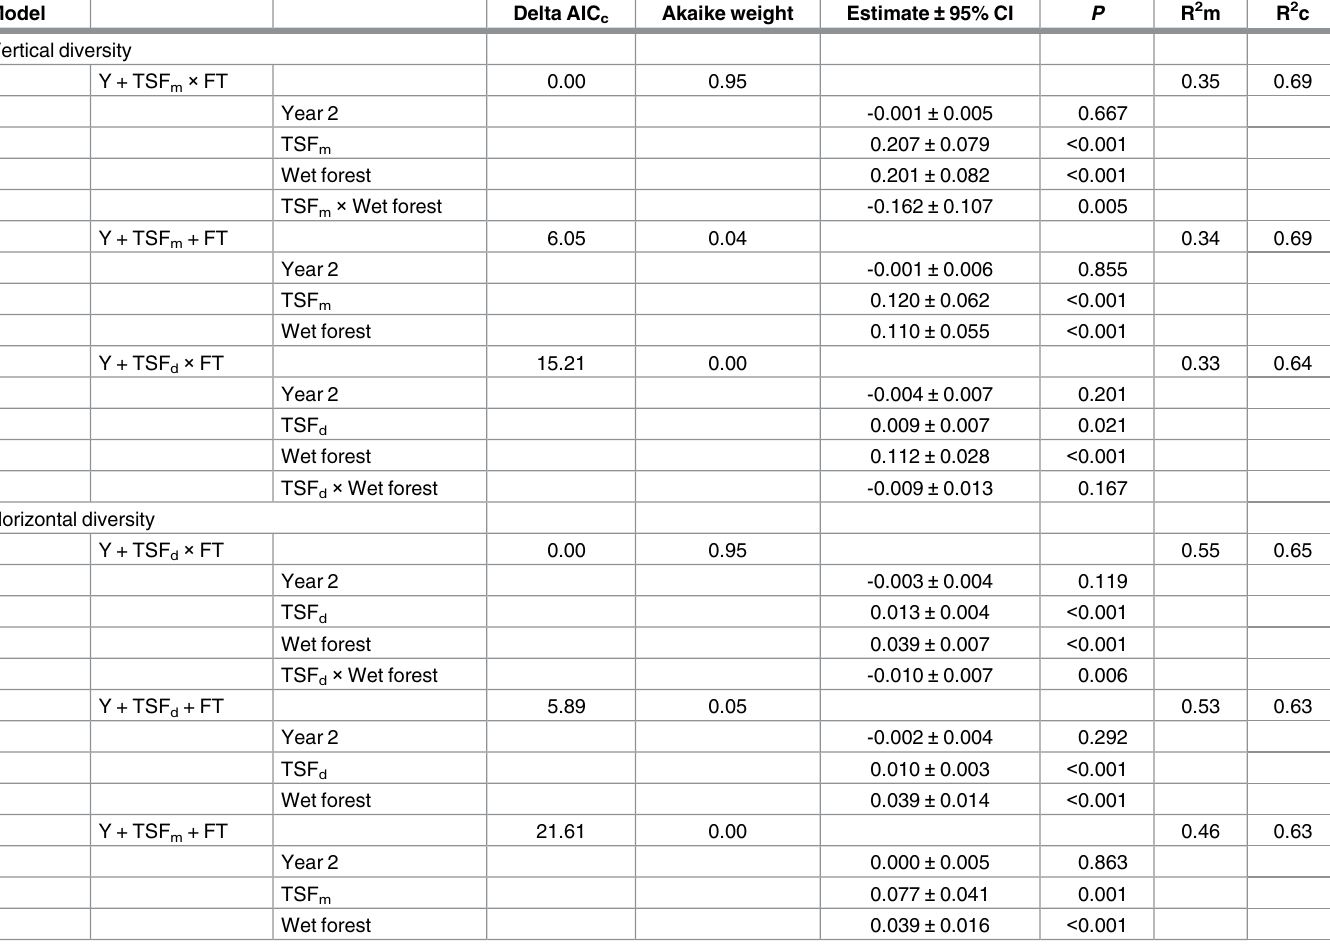
Estimates associated with wet forest represent contrasts with dry forest, and estimates associated with Year 2 represent contrasts with Year 1. Models were ranked using Akaike’s information criterion corrected for small sample size (AIC c ), and the three highest-ranked models per set are displayed with Akaike weights. Parameter estimates with 95% confidence intervals (CI) are displayed with their statistical significance ( P ). Two measures of fit are provided: marginal R 2 m (R 2 m) is the variance explainedby fixed factors and conditional R 2 (R 2 c) is the variance explainedby both fixed and random